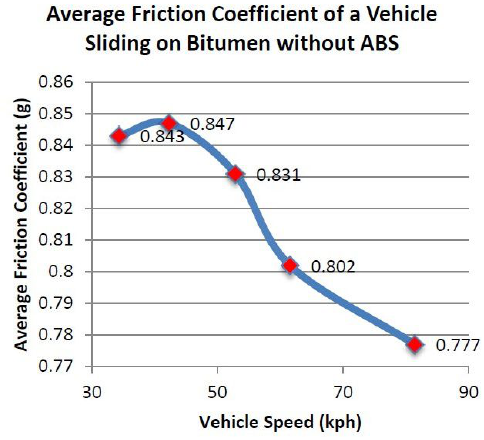
Fig. 6. Average friction coefficient of a skidding vehicle without antilock braking system (ABS).